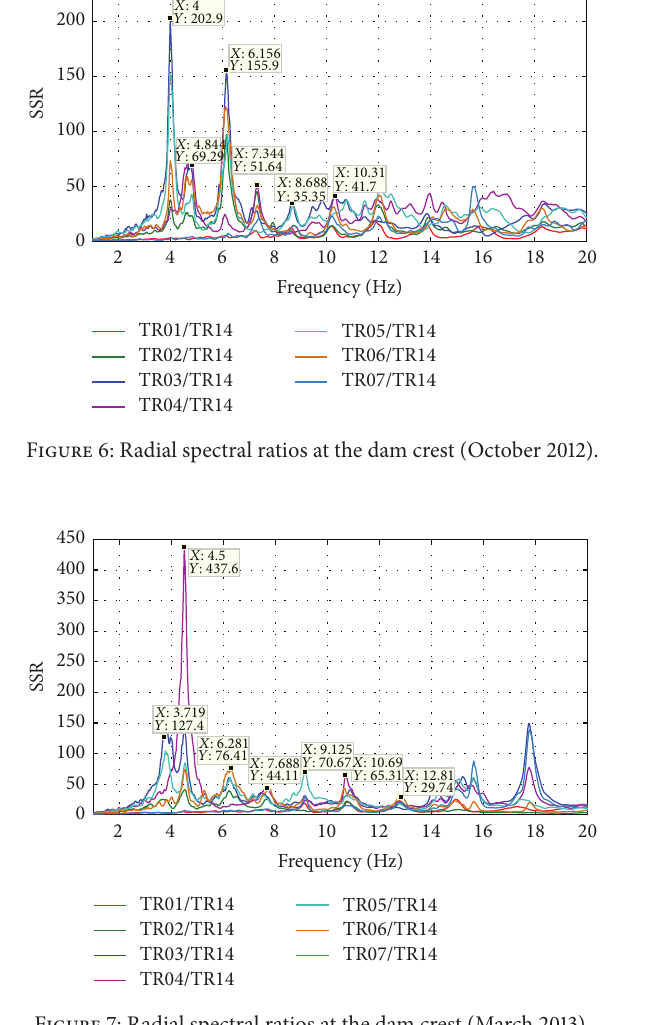
Figure 7: Radial spectral ratios at the dam crest (March 2013).